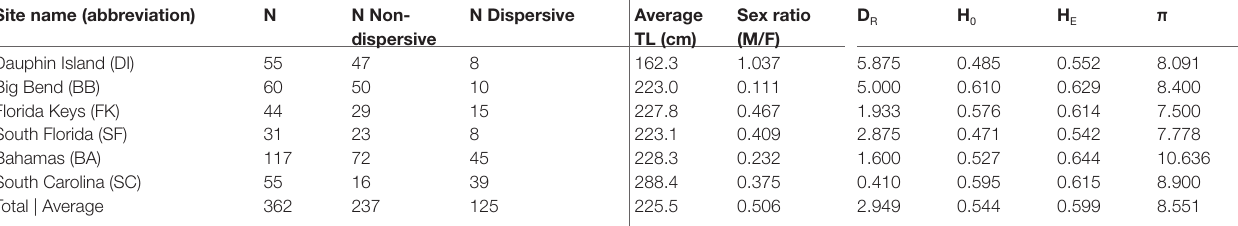
TABLE 1 | Demographics and diversity indices for each sampling